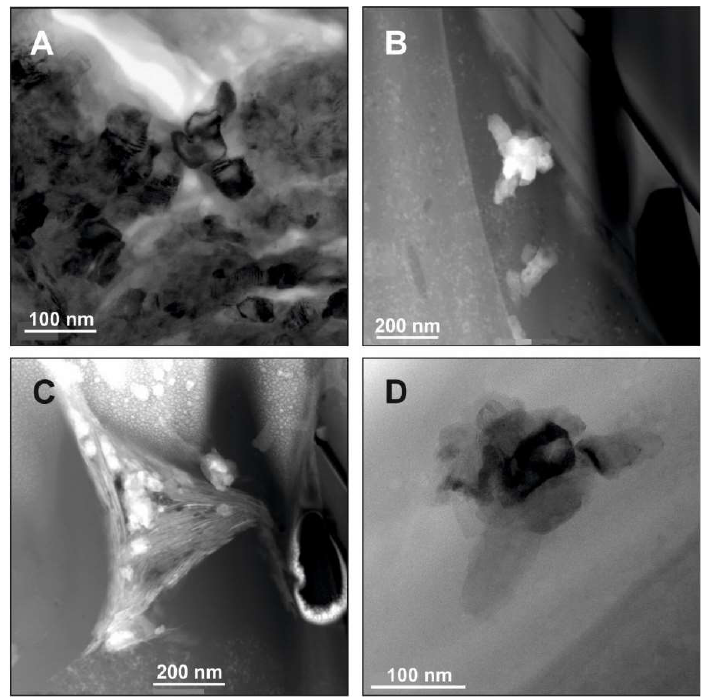
Figure 3. Titania (TiO 2 ) polymorphs (brookite in all selected samples) in the Dictyonema Shale (Tremadocian, Ordovician). ( A , D ) are TEM Bright Field images whereas ( B , C ) are high-magnification scanning transmission electron microscopy (STEM) images (high-angle annular dark-field (HAADF) mode). ( A ) The sample originates from a well core from a depth of 52.05 m, has a TOC content of 12.20%, and is early mature (hydrogen index, HI: 191 mg HC/g TOC; T max : 414 °C). ( B , C , D ) The sample originates from a well core from a depth of 52.40 m, has a TOC content of 6.15%, and is early mature (hydrogen index, HI: 95 mg HC/g TOC; T max : 414 °C).